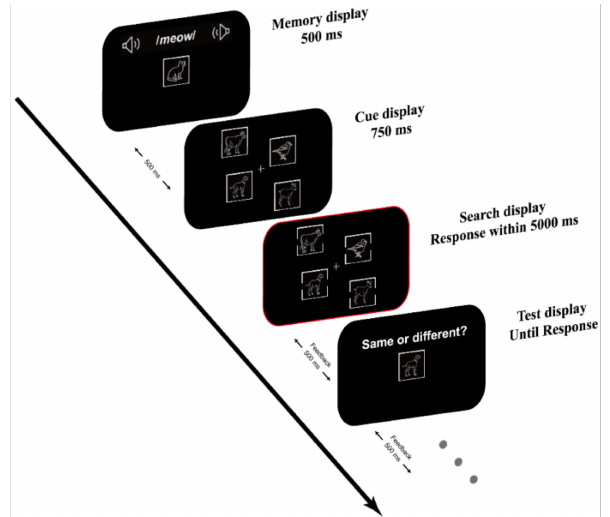
Figure 1. Procedure of events in a sample trial. Participants were asked to remember the memory sample (visual or congruent audiovisual) and complete a change-detection task in the test (here, the identity changed). In the retention interval, they searched and specified which side of the target had a larger gap. One of the distractors could match the identity or neither feature with the memory item. Between the memory display and the search display, a cue array was presented, providing prior knowledge of the identity and location of search